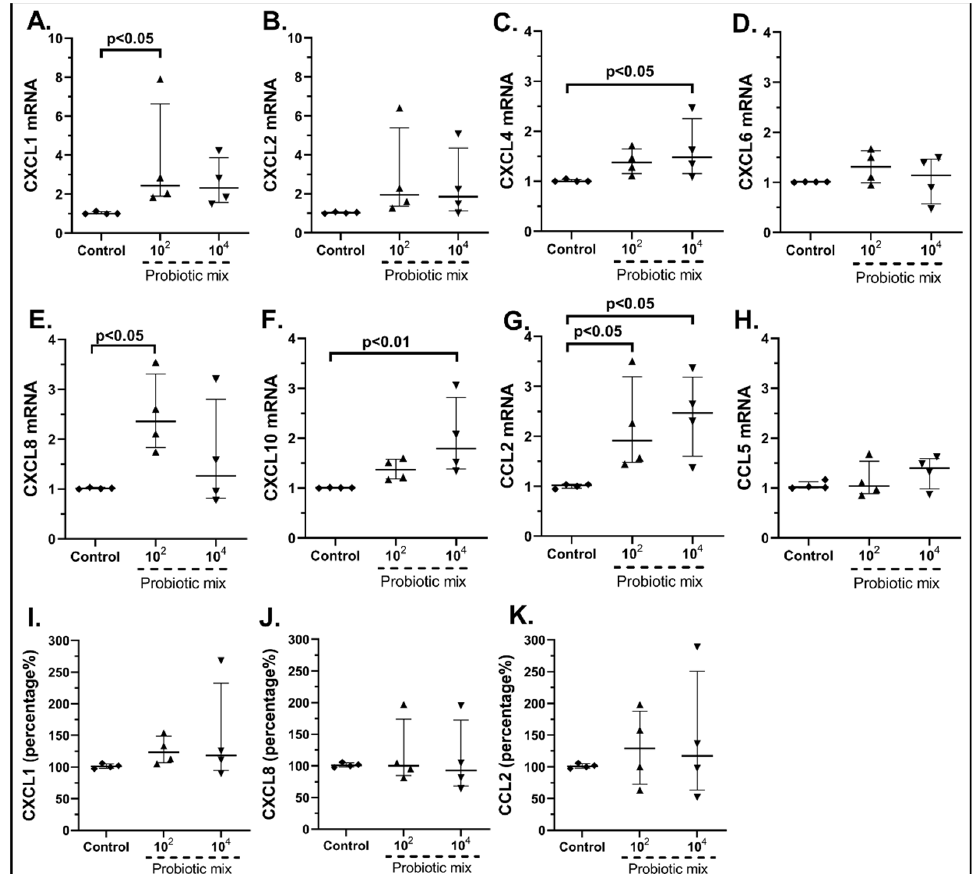
Figure 2. cSEMF mRNA expression of CXCL1 ( A ), CXCL2 ( B ), CXCL4 ( C ), CXCL6 ( D ), CXCL8 ( E ), CXCL10 ( F ), CCL2 ( G ) and CCL5 ( H ) and protein levels of CXCL1 ( I ), CXCL8 ( J ) and CCL2 ( K ) after stimulation with the probiotic mix of Bifidobacterium lactis, Lactobacillus acidophilus, Lactiplantibacillus plantarum and Saccharomyces boulardii. Results are presented as median with interquartile range. N = 4.